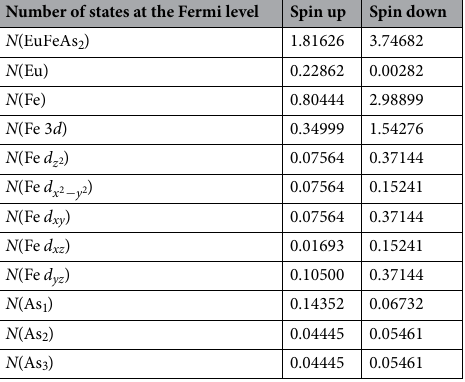
Table 2. The total and partial DOS (in states/eV) in EuFeAs 2